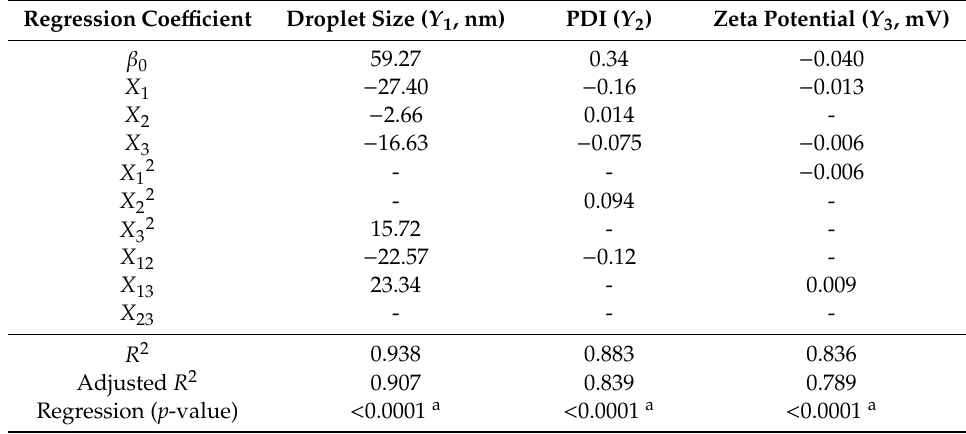
Table 4. Regression coe ffi cients, R 2 , adjusted R 2 , and probability values for the final reduced equation. Regression Coe ffi cient